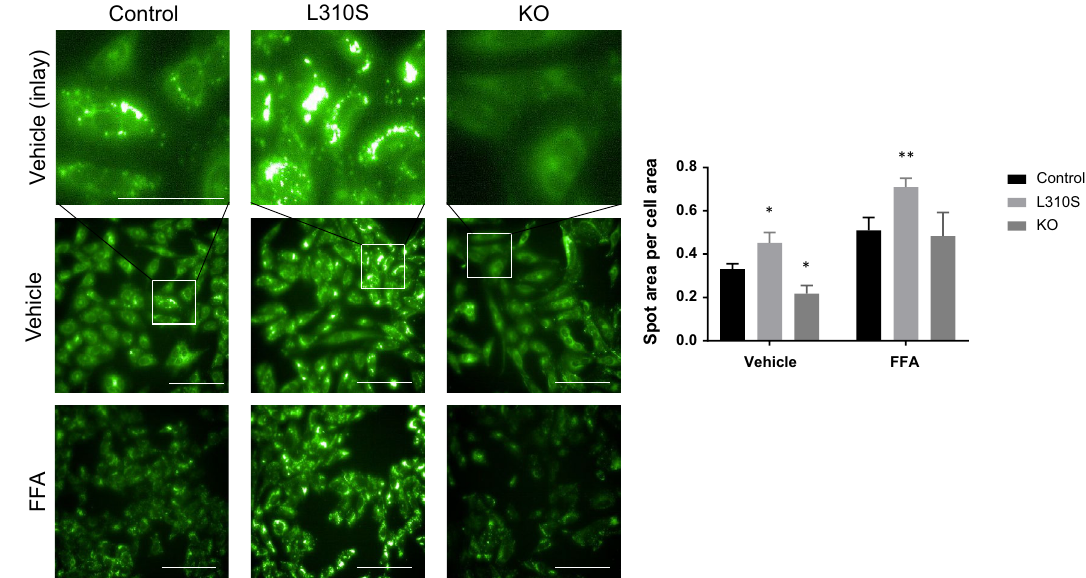
Figure 8. Mutant SNU449 phenotypic characterization. ( A ) LipidTox neutral lipid stain reveals that under basal conditions, mutant SNU449 CRSIPR-Cas9 engineered cell lines show altered lipid burdens. The L310S line demonstrates an increased lipid burden and the KO line shows a reduced lipid burden. Under 25 µM free fatty acid treatment, all three lines demonstrate an increased lipid burden, with the L310S line demonstrating the greatest signal intensity for LipidTox neutral lipid stain. Scale bar represents 100 µM in all images, except for inlays where the scale bar represents 50 µM. Image thresholding was optimized for both vehicle and fatty acid conditions to highlight differences across lines. Within a treatment condition, image thresholding is constant. ( B ) Quantitative image analysis demonstrates a significant increase in LipidTox spot area per cell area in the L310S line relative to control (adjusted p-value of 0.0130). The KO line shows a significantly reduced lipid burden under basal conditions as measured by a significant decrease in neutral lipid spot area per cell area relative to control (adjusted p-value of 0.0213). Upon free fatty acid exposure the L310S line demonstrates a significant increase in lipid accumulation as measured by LipidTox spot area per cell area (adjusted p-value <